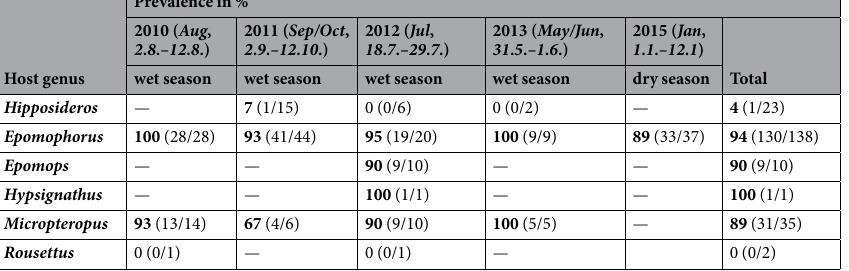
Table 1. Prevalence in Pteropodidae and Hipposideridae. Table 1 lists prevalences of Hepatocystis infections in the bat host families Hipposideridae and Pteropodidae. Given are prevalences in % and total numbers of infected per total investigated individuals per host genus in the corresponding sampling